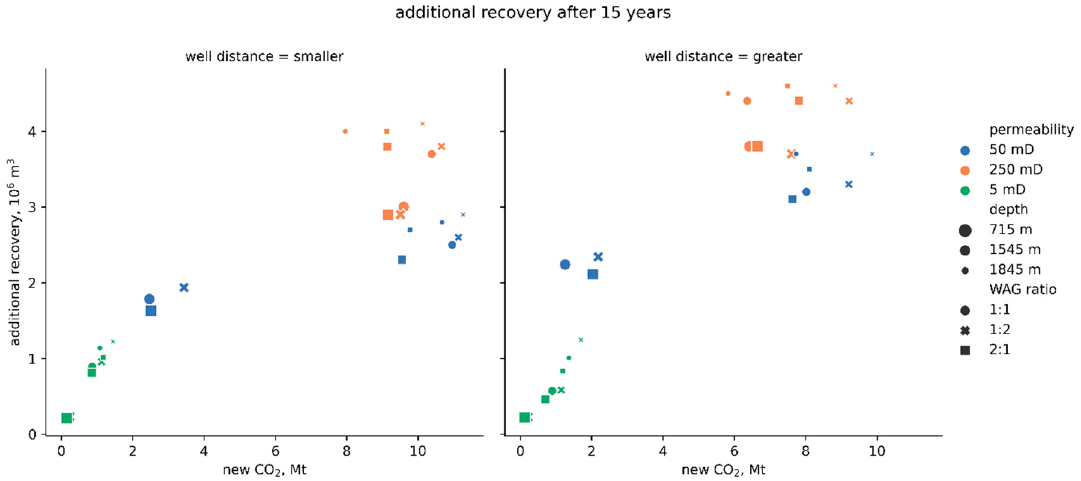
Figure A9. Additional recovery versus new CO 2 after 15 years of EOR.